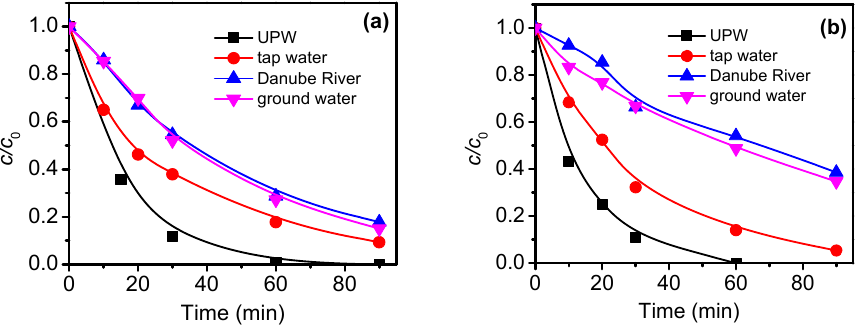
Figure 8. Efficiency of FB 1 (1.39 μ mol/dm 3 ) degradation in different types of water using: ( a ) UV/H 2 O 2 treatment at natural pH~8; ( b ) UV/S 2 O 82 − treatment at pH~8. c(H 2 O 2 ) = 0.278 mmol/dm 3 , c(S 2 O 82 − ) = 0.140 mmol/dm 3 .